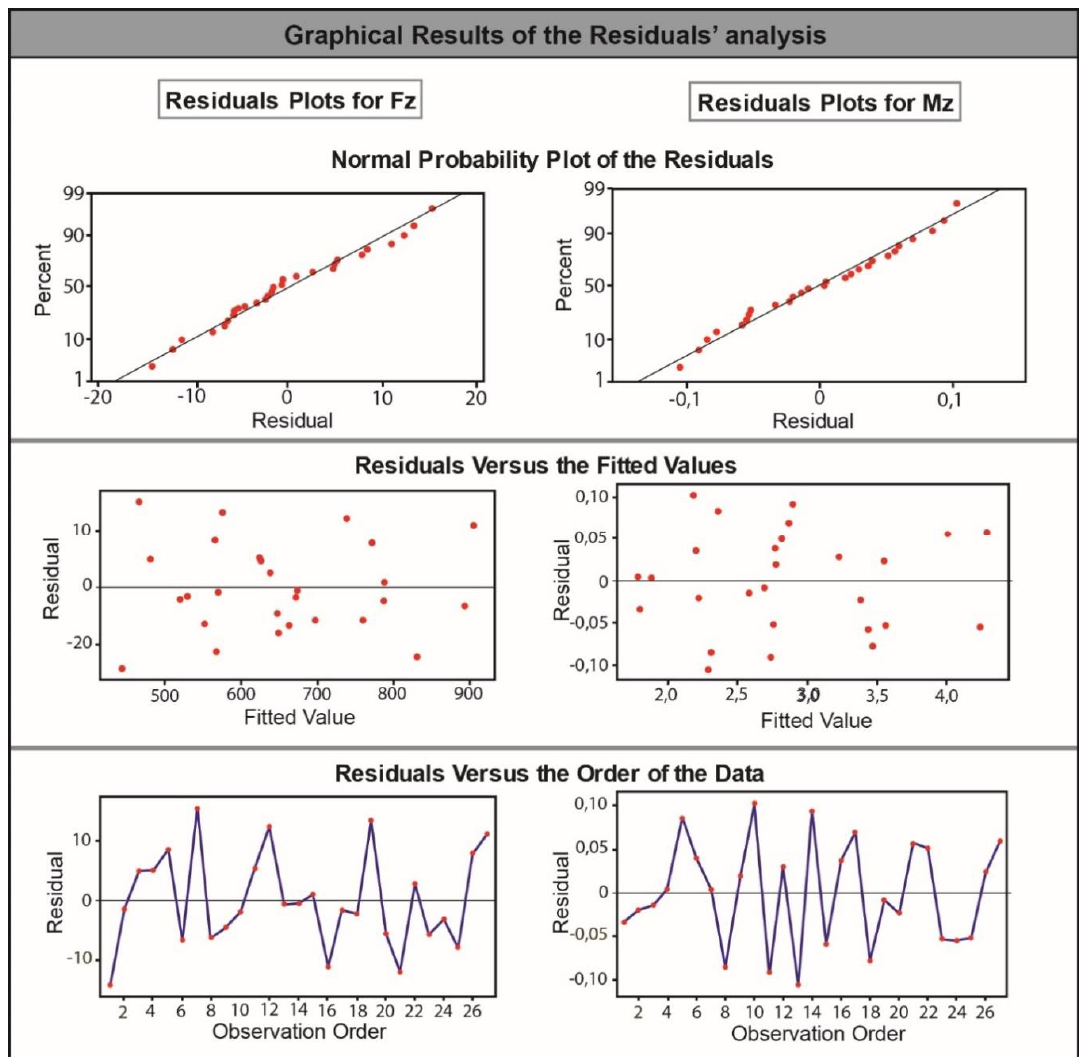
Figure 7. Residuals analyses for the F z and M z .